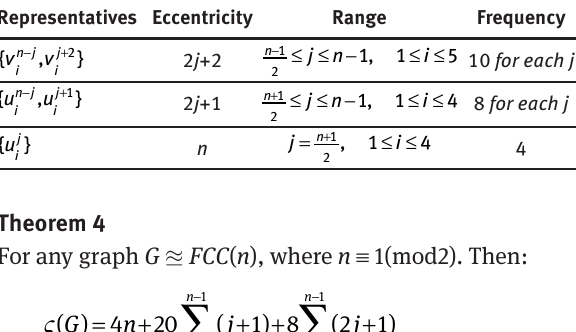
Table 4: Eccentricity based vertex partition of FCC ( n ) for n ≡ 1(mod2) Representatives Eccentricity Range